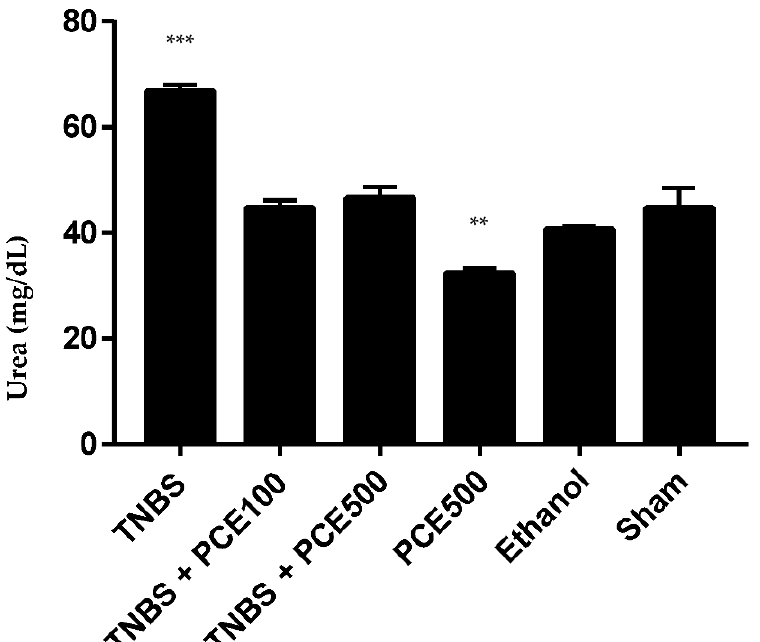
Figure 5. Effect of PCE treatment on urea concentration in the IBD. The results are represented as mean ± SD [ n (TNBS + PCE100) = 10; n (TNBS + PCE500) = 10; n (PCE) = 10; n (TNBS) = 6; n (Ethanol) = 5; n (Sham) = 5; ** p < 0.01; *** p < 0.001 compared with sham group, one-way ANOVA followed by Tukey’s post hoc test]. Abbreviations: IBD, inflammatory bowel disease; PCE, phenolic compounds extract; TNBS, 2,4,6-Trinitrobenzene sulfonic acid.